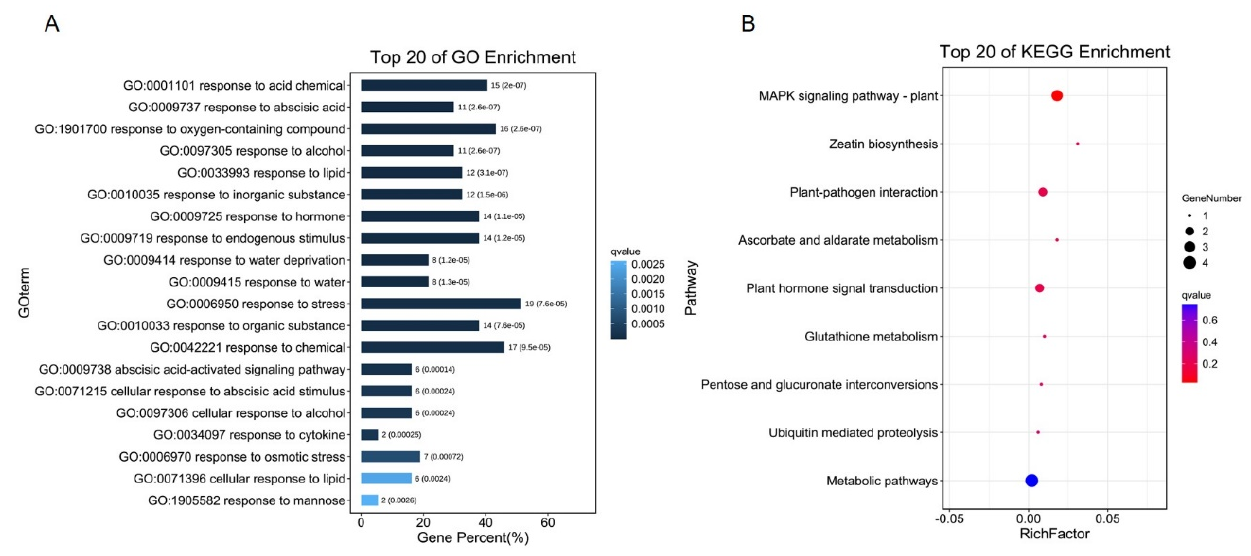
Figure 8. GO term and KEGG enrichment analyses of DEGs. ( A ) Top of 20 GO term enrichment. The vertical coordinates are the enriched GO terms, and the horizontal coordinates are the numbers of the DEGs. ( B ) KEGG enrichment analysis of DEGs. The vertical coordinates are the enriched pathways, and the horizontal coordinates are the rich factors. The size of each point represents the number of DEGs in the pathway, and the point color represents the q -value.